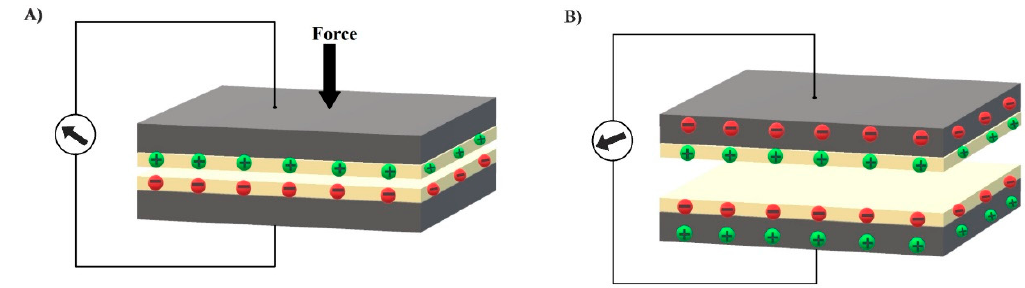
Figure 10. Flexible triboelectric sensor’s schematic illustration ( A ) transduction principle when force is applied, ( B ) potential difference produced when force is released.